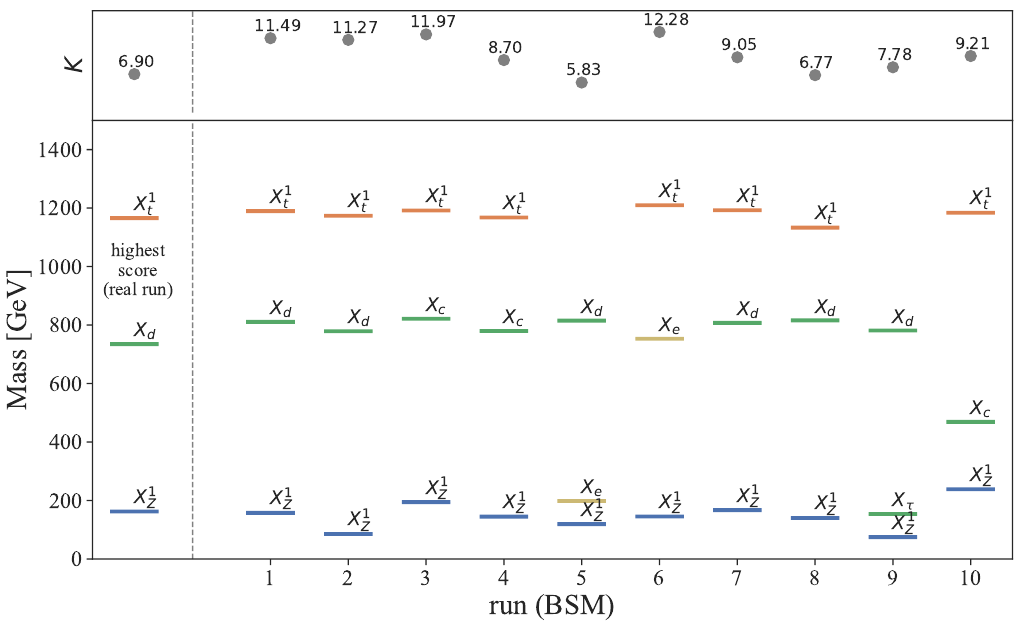
Figure 10 . Particle content and masses for the proto-models with highest test-statistic K obtained in each of the 10 runs performed over the fake databases generated under the “BSM hypothesis”. The corresponding K values are shown at the top. The spectrum of the proto-model used for the injected signal is shown on the left.